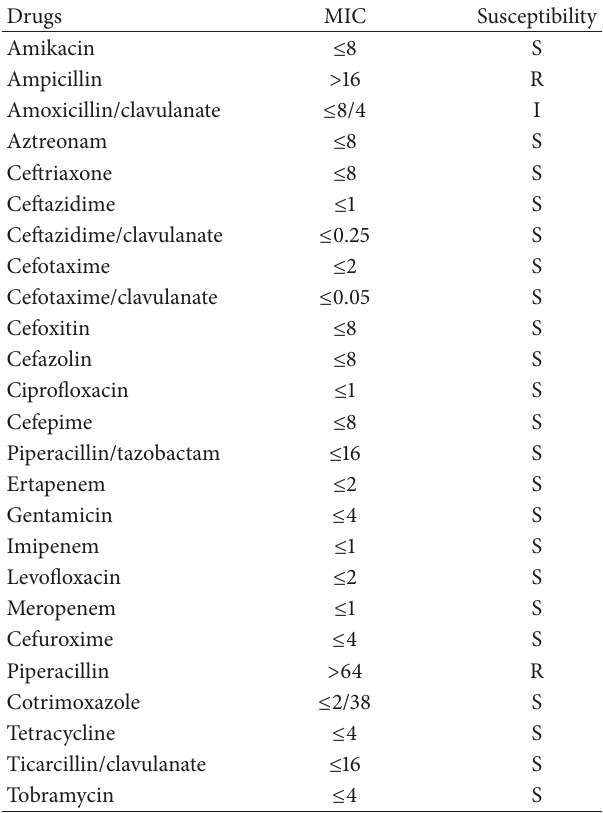
Table 1: Susceptibility of the isolated Y. regensburgei